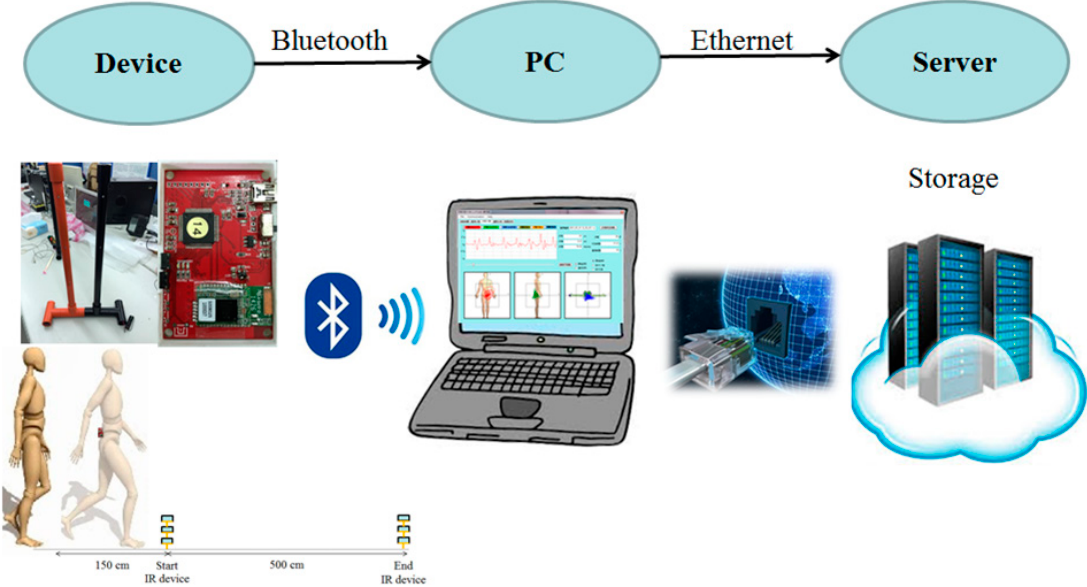
Figure 3. The IR-assist accelerometer-based gait analysis system has a wireless sensor unit, an IR unit, a laptop, and cloud storage database. PC, personal computer.